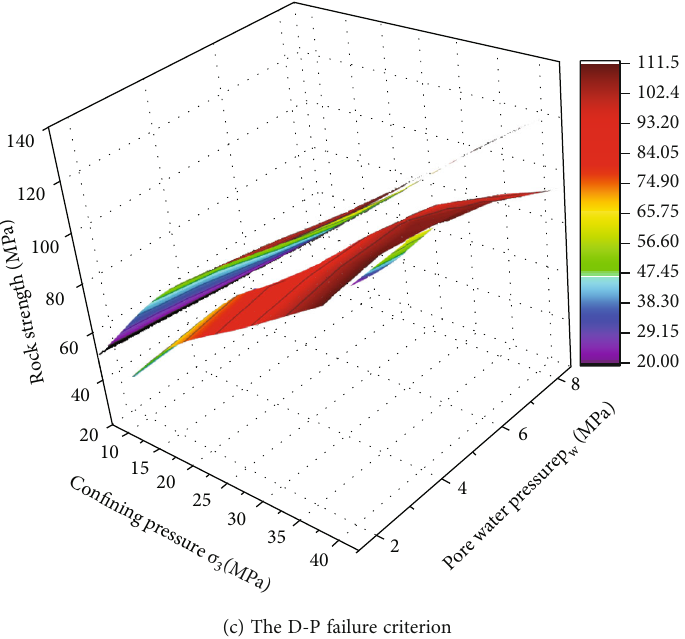
Figure 4: Comparison between di ff erent failure criteria and test results. Table 2: Model-relative error results.